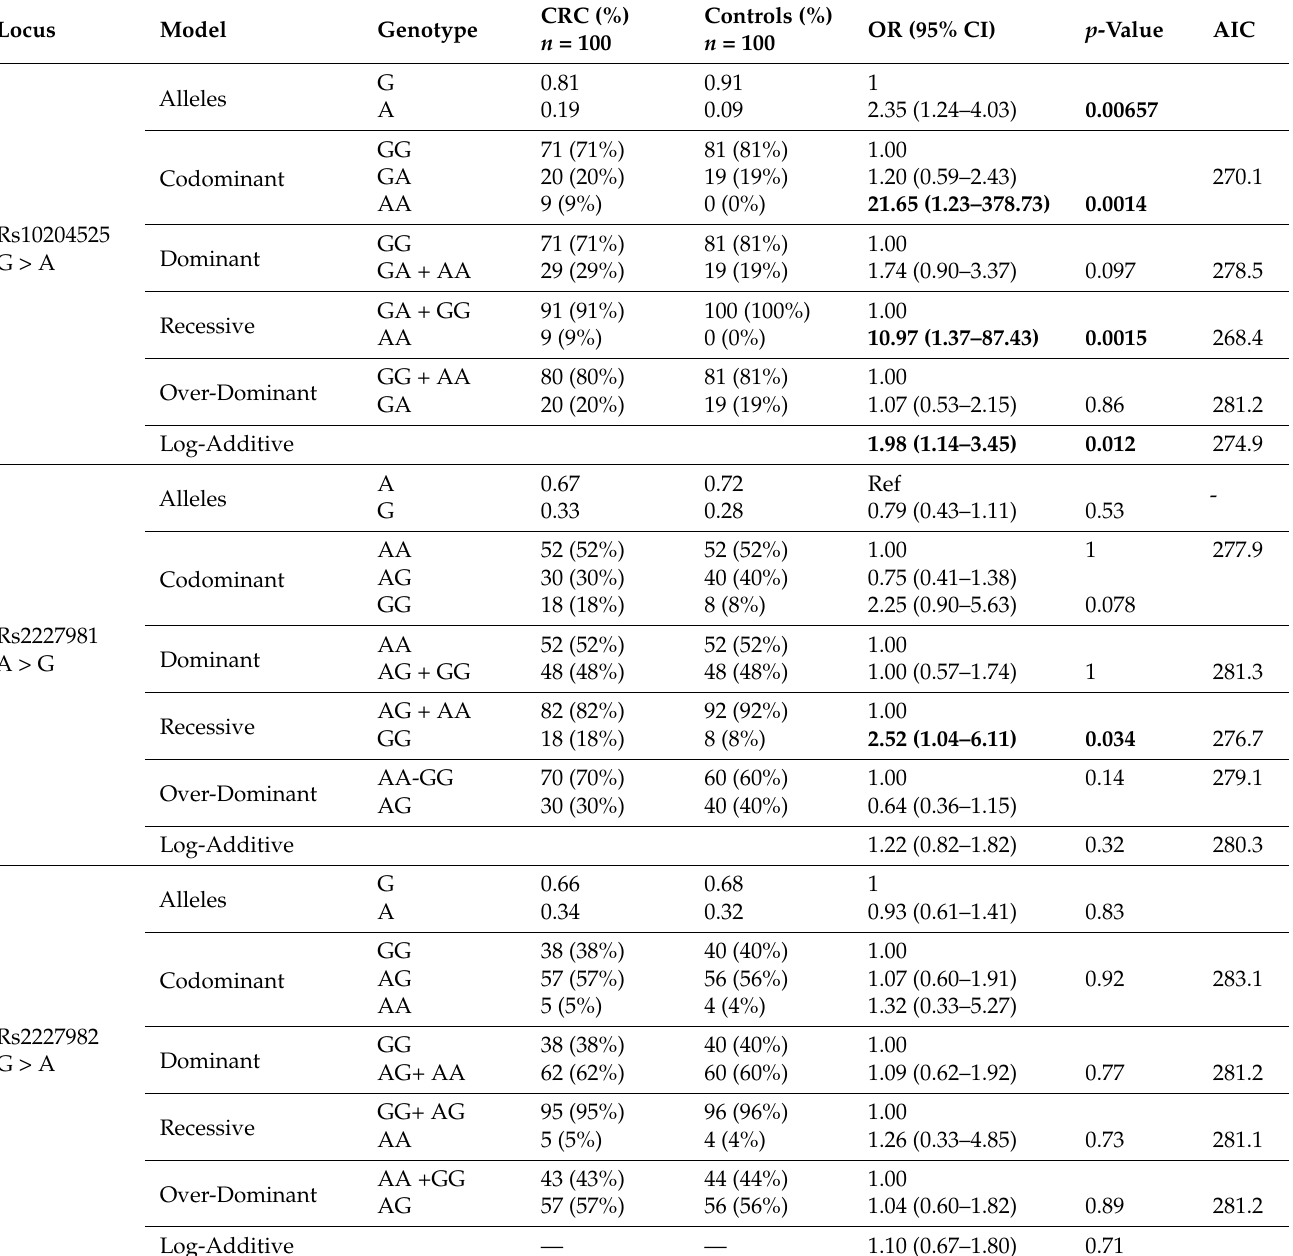
Table 3. Distribution of PD-1 SNPs genotypes and allele frequencies in colorectal cancer cases and a control